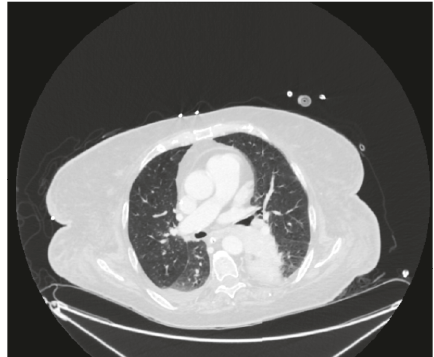
Figure 1: Computed tomography of the chest showing a large mediastinal obstructive mass in the left chest.